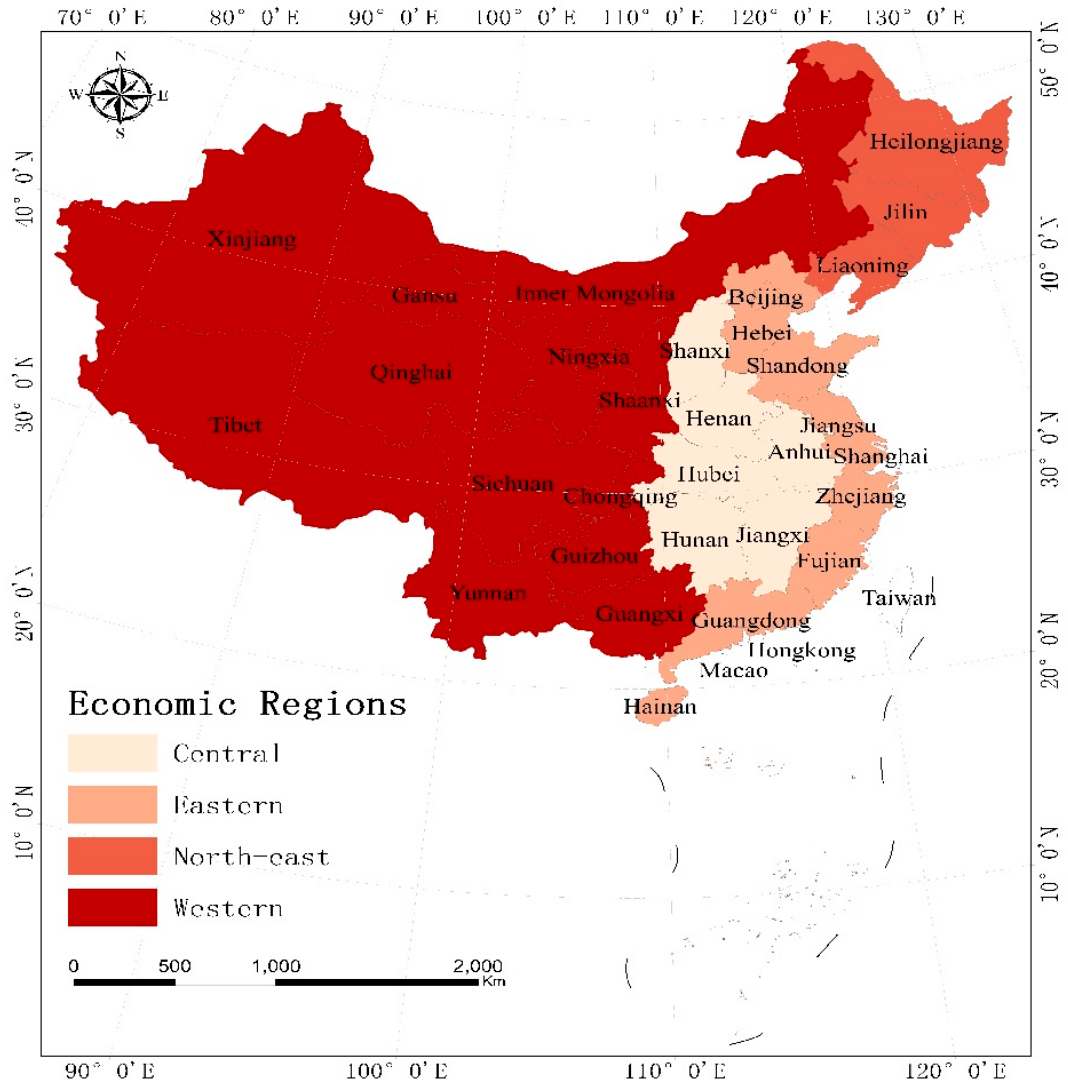
Figure 1. Map of the research area.